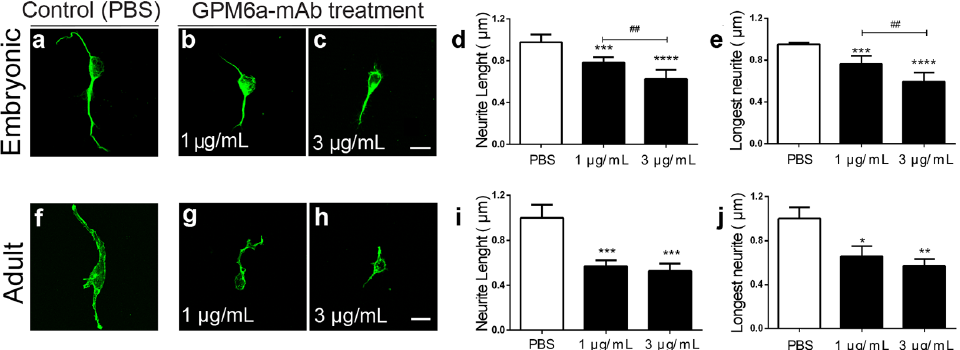
Figure 4. Blocking endogenous GPM6a impairs neurite elongation in cultured DRG neurons. Rep- resentative images show embryonic and adult dissociated DRG neurons treated ( b , c , g , h ) or not ( a , f , control condition) with the neutralizing GPM6a-mAb antibody for 24 h. DRG neurons were stained with Tuj-1-mAb (green). Scale bars represent 10 µ m. The neurite length ( d , i ) and the longest neurite ( e , j ) were quantified with ImageJ software using the NeuronJ plugin. Results are expressed as mean + SEM of N = 2–4 independent experiments with 15–25 cells per condition. Each experiment had at least three wells per condition (n = 3 technical replicates). Two-way ANOVA followed by Bonferroni post-test calculations were used. The results were considered significant when p < 0.05. * p < 0.05, ** p < 0.01, *** p < 0.005, and **** p < 0.001 for PBS vs. GPM6a-mAb, 1 µ g/mL, or 3 µ g/mL; and ## p < 0.01 for GPM6a-mAb 1 µ g/mL vs. GPM6a-mAb 3 µ